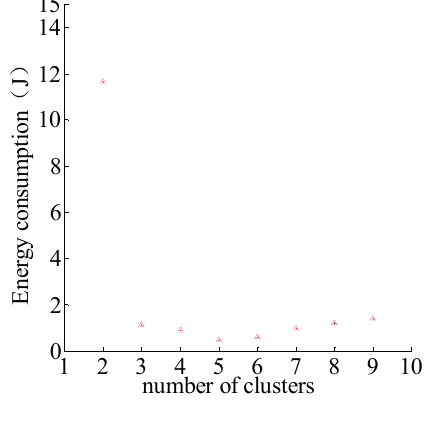
Figure 6. Different number of clusters-energy consumption